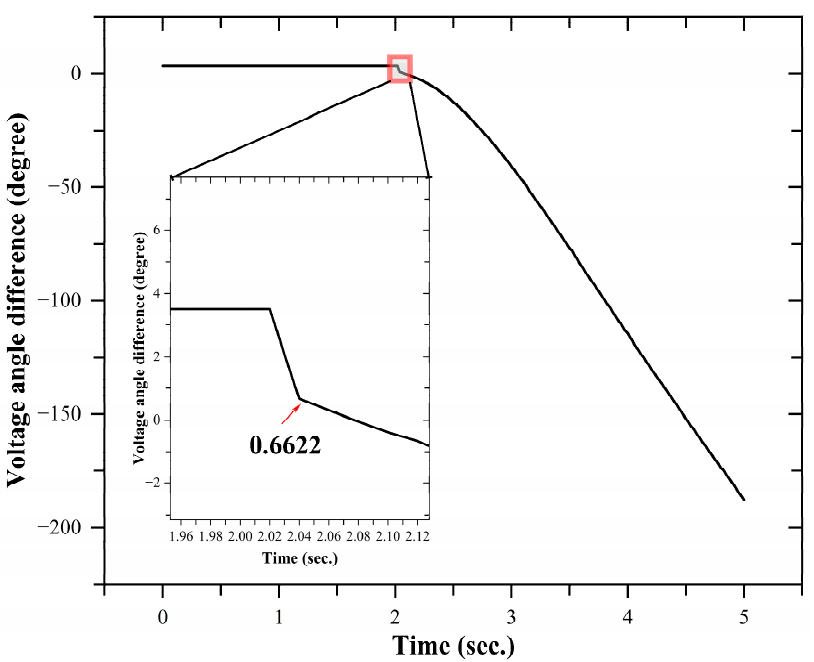
Figure 12. Proposed unintentional island threshold technique for under frequency Scenario 4.